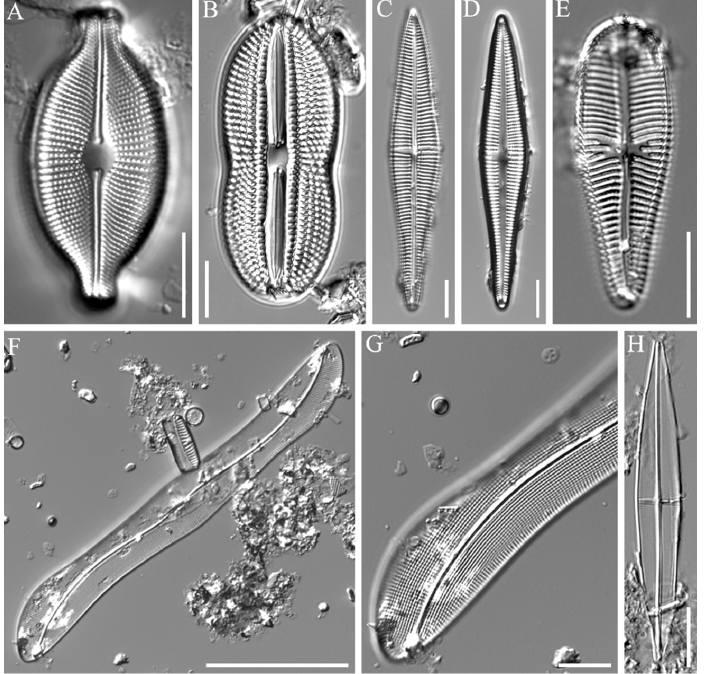
Figure 2. Light micrographs of diatoms. ( A ) Cosmioneis citriformis ( B ) Diploneis didyma ( C , D ) Gomphonema guaraniarum ( E ) Gomphonema italicum ( F , G ) Gyrosigma sinense ( H ) Haslea crucigera . Scale bars. 2–6, 8, 9:10 µ m; 7:50 µ